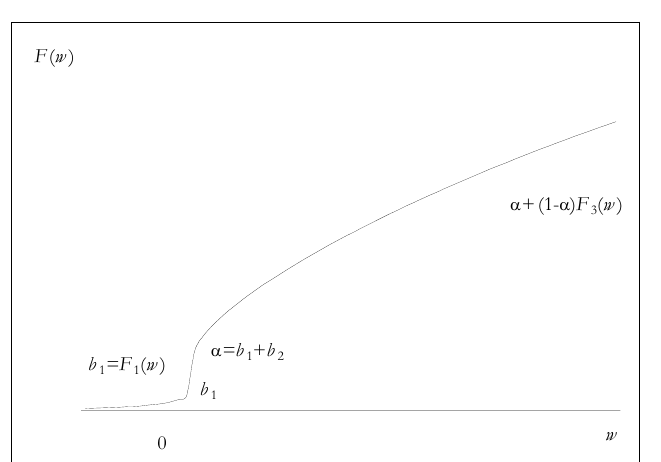
Figure 2 – Cumulative distribution function of a net wealth distribution, 0< b 2 <1.